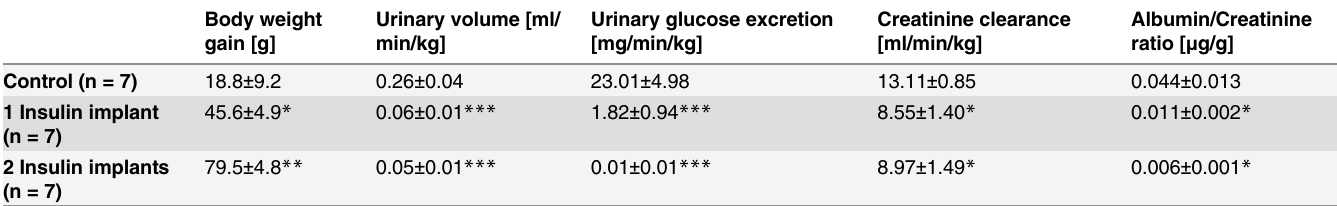
Table 1. Body weight gain (day 25 after implantation) and renal parameters in STZ-diabetic rats 27 days after implantation of insulin implants (1 or 2 implants/animal). * p < 0.05, ** p < 0.01, *** p < 0.001 vs.